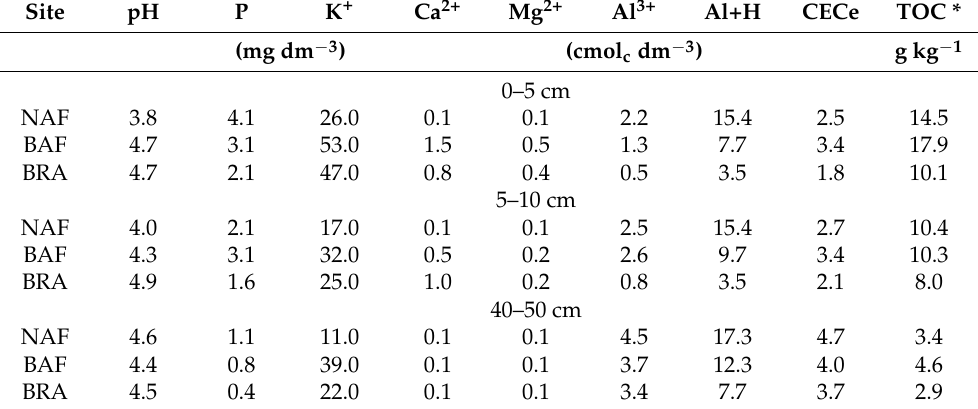
Table 1. Values of pH, available phosphorous (P) and potassium (K + ), exchangeable calcium (Ca 2+ ), magnesium (Mg 2+ ) and aluminum (Al 3+ ) content, potential acidity (Al+H), effective cation ex- change capacity (CECe) and total organic carbon content (TOC) of soil samples collected at 0–5, 5–10 and 40–50 cm depth at the native Amazon Forest (NAF), burned Amazon Forest (BAF) and Brachiaria (BRA)